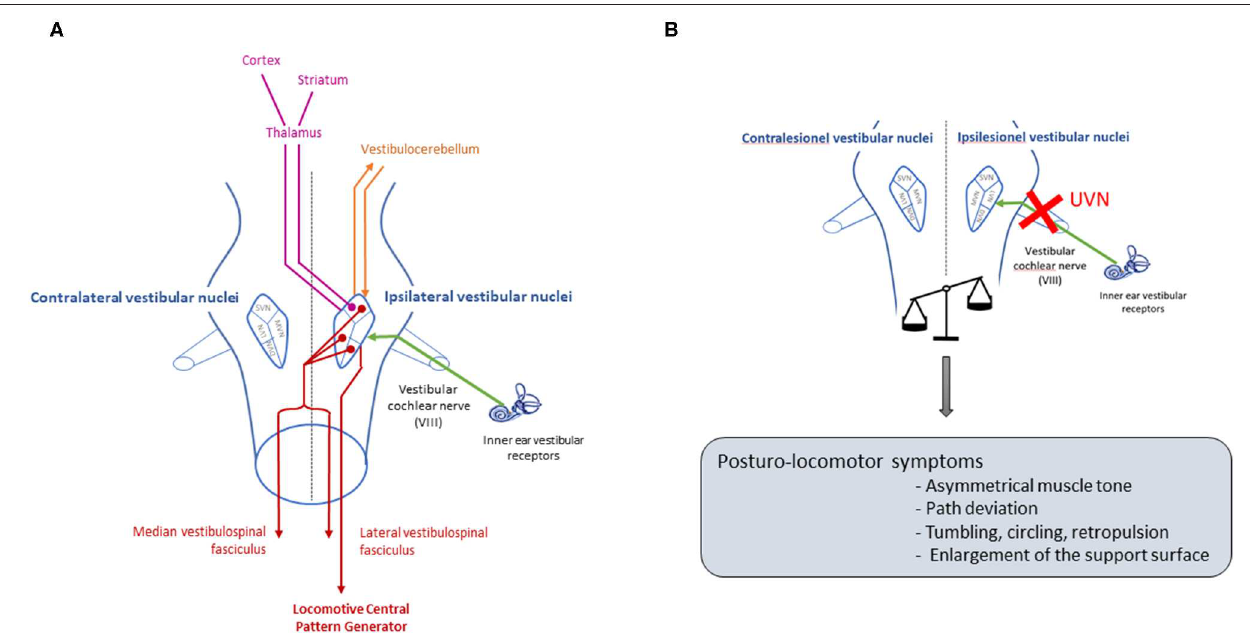
FIGURE 1 | Pathways involved in posturo-locomotor function of the vestibular system, and deficits after unilateral vestibular neurectomy. (A) The vestibular nerve transmits information from peripheral vestibular receptors to the four vestibular nuclei located in the brain stem [medial vestibular nucleus (MVN), lateral vestibular nucleus (LVN), superior vestibular nucleus (SVN) and inferior vestibular nucleus (DVN)]. The vestibular nuclei then project toward various structures involved in the control of posturo-locomotor function: the spinal cord (17), the cerebellum (18), the striatum (19) and different cortical zones such as the motor cortex (20). The medial vestibulospinal fasciculus sends ipsi and contralateral projections to motoneurons of the neck muscles, allowing head stabilization, while the lateral vestibulospinal fasciculus projects ipsilaterally to the trunk and leg muscles, allowing anti-gravitary muscle tone, and to the locomotor CPG responsible for automatic locomotion coordination. The vestibular nuclei receive and transmit information to the vestibulocerebellum, involved in posture control, and via a thalamic relay, the vestibular nuclei project toward the striatum which is involved in locomotion control. The vestibular nuclei therefore constitute a central relay for the control of posture and locomotion, and a unilateral vestibular loss that induces electrophysiological imbalance between the homologous vestibular nuclei will generate a characteristic posturo-locomotor syndrome that affects each level of the neural network described above. (B) UVN will cause an electrophysiological asymmetry between homologous vestibular nuclei (21). Due to all the pathways previously described, this electrophysiological asymmetry will lead to various posture-locomotor symptoms.